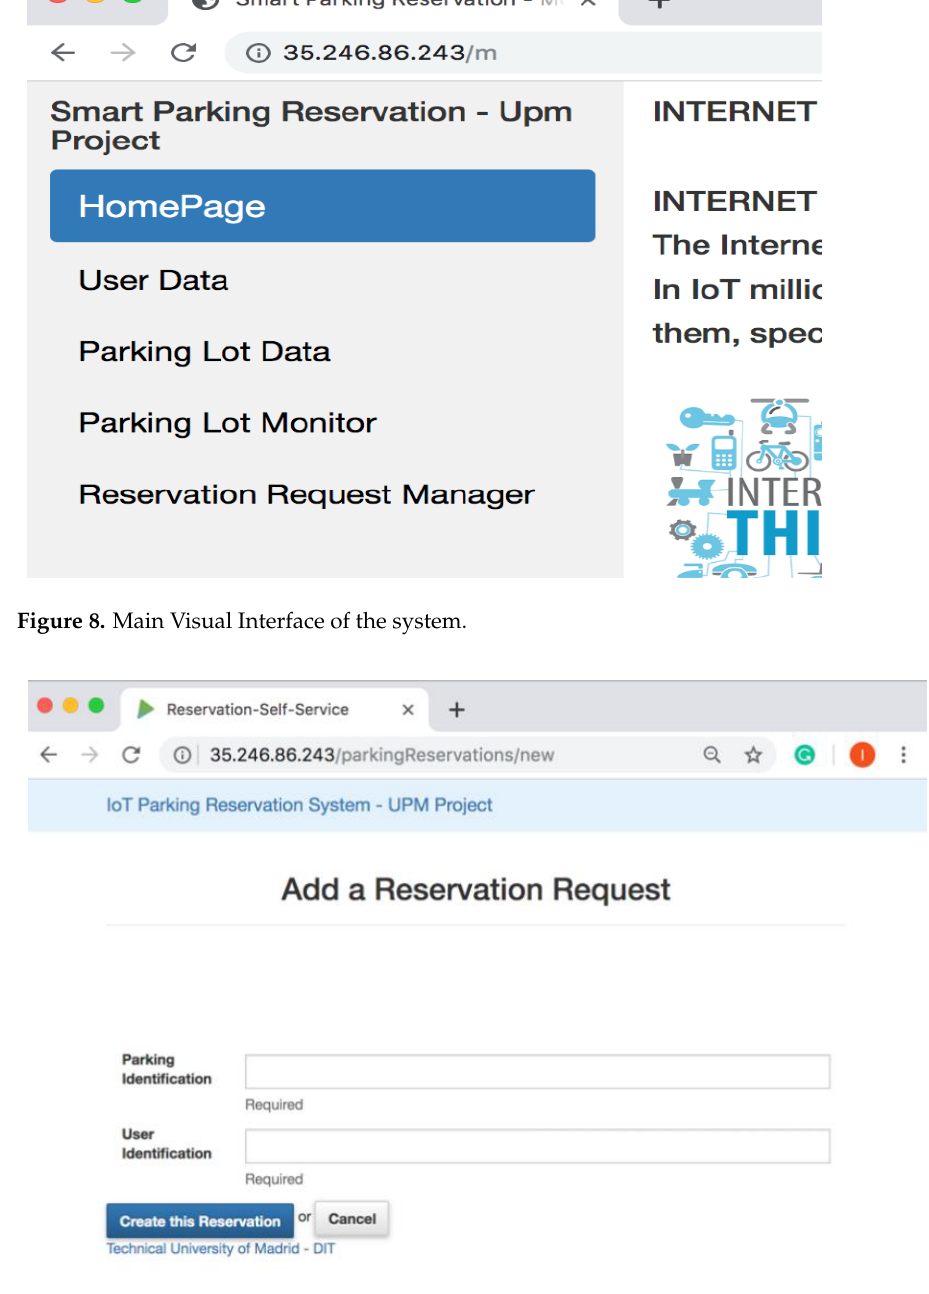
Figure 9. Reservation Request Service interface.